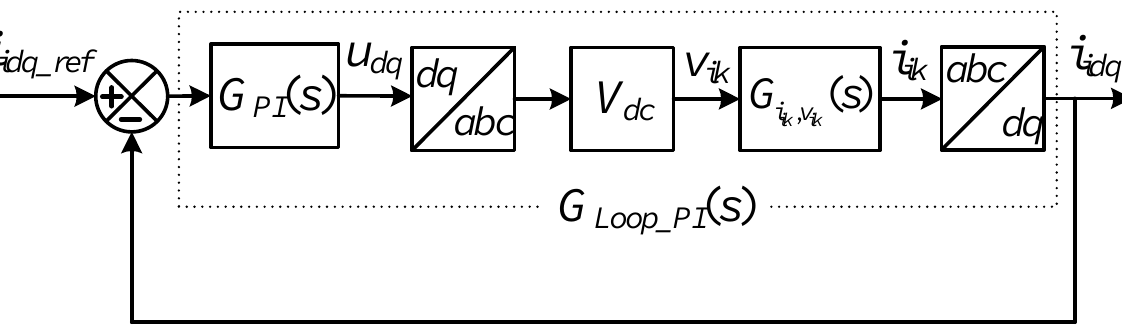
Figure 4. Block diagram of single-loop PI control for L or LCL filter type GcI.